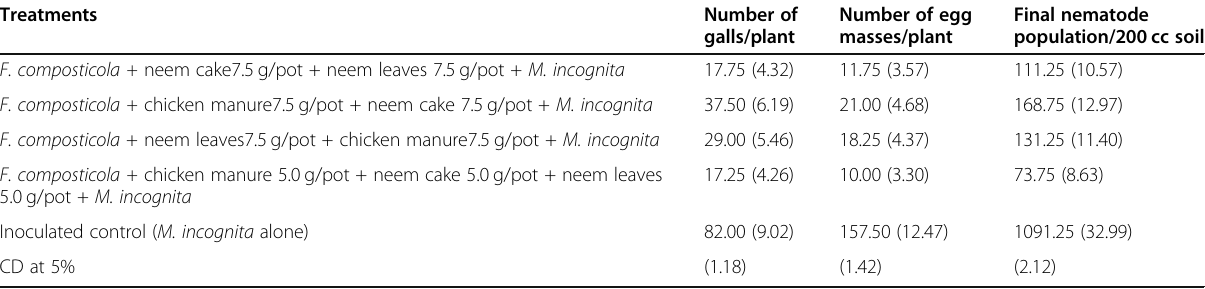
Figure in the parentheses are square root transformed values